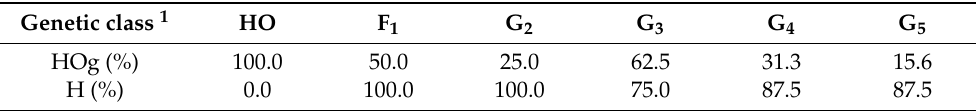
Table 2. Characteristics of genetic classes as a function of the combination of the percentage of Holstein genes (HOg) and coefficient of heterosis (H). Genetic class 1 HO F 1 G 2 G 3 G 4 G 5 HOg (%) 100.0 50.0 25.0 62.5 31.3 15.6 H (%) 0.0 100.0 100.0 75.0 87.5